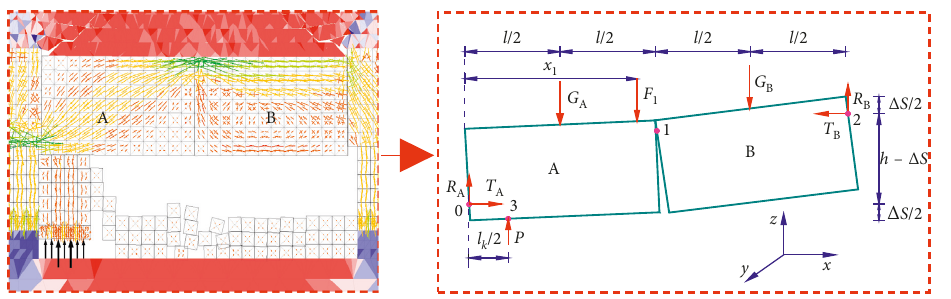
Figure 8: Force analysis of the fracture